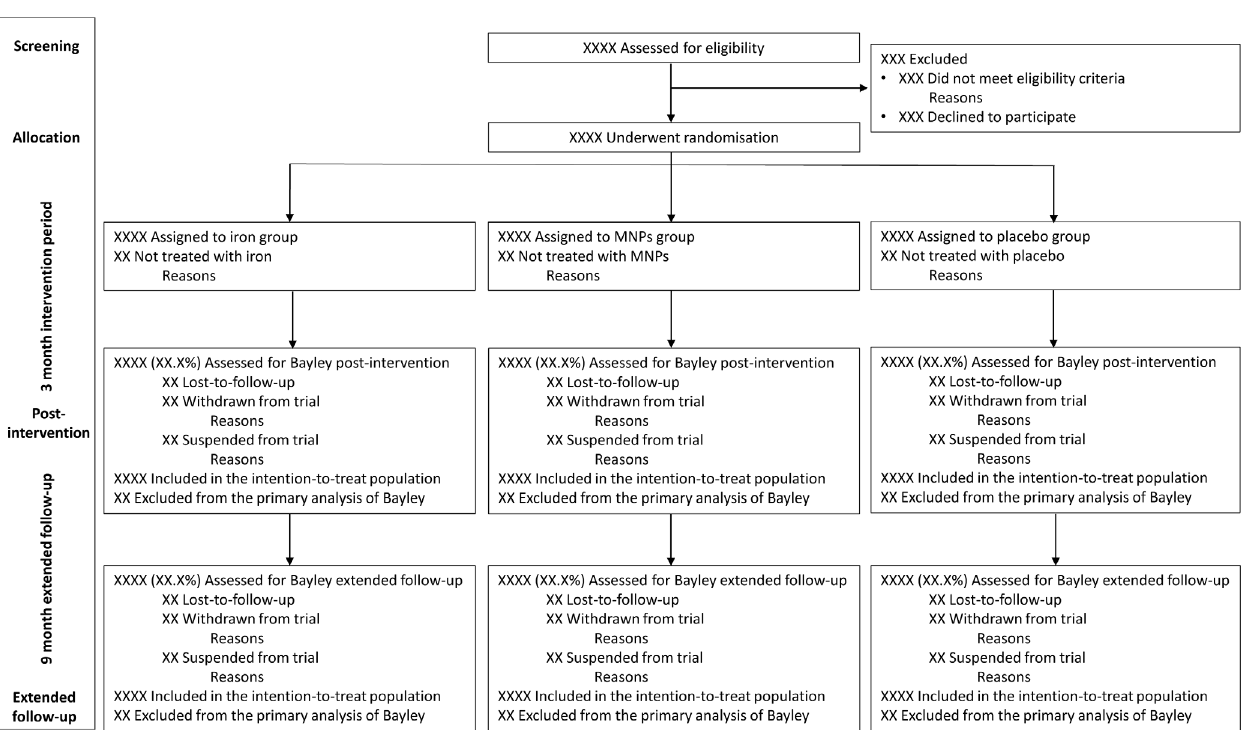
Figure 2. The CONSORT flow chart. MNPs denotes multiple micronutrient